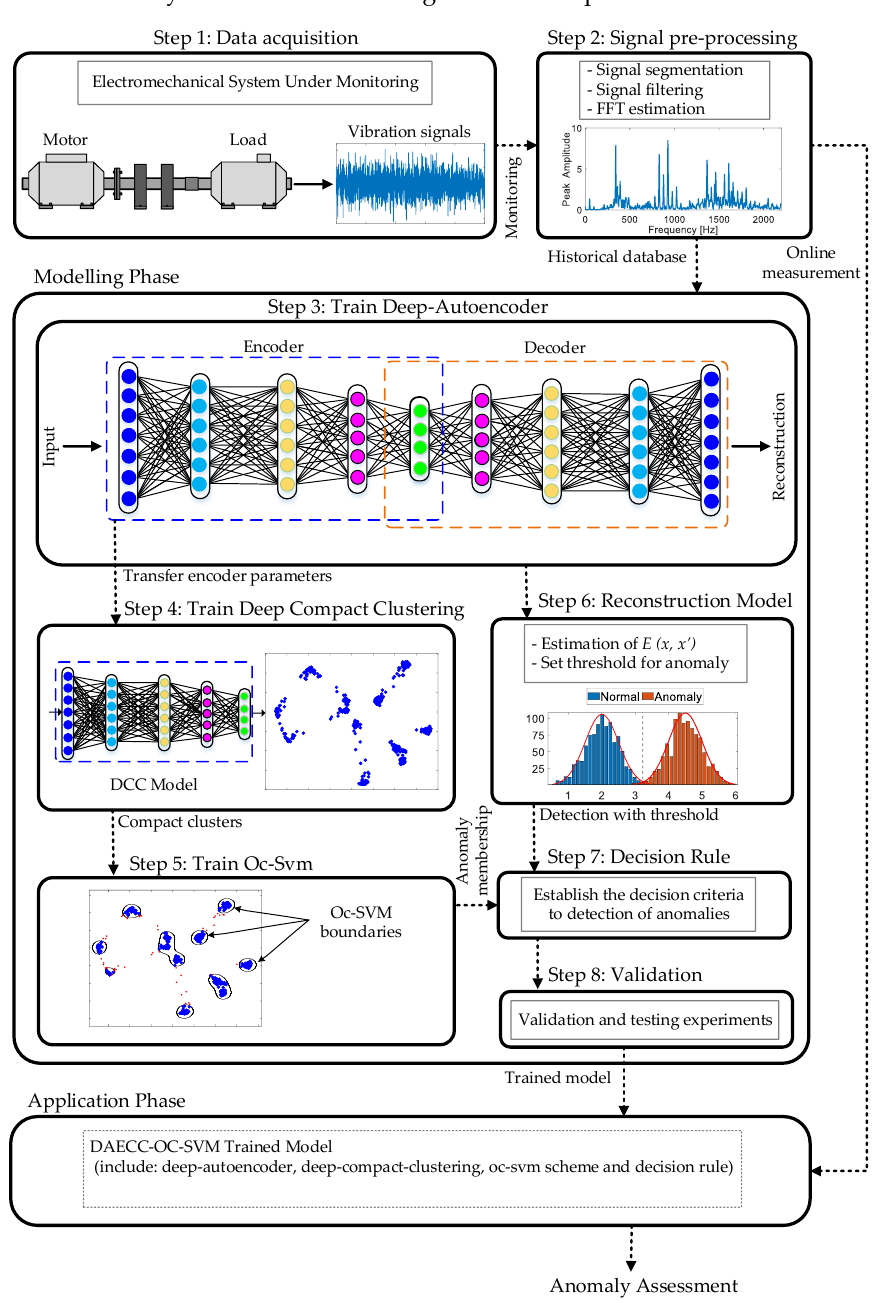
Figure 3. Framework of the proposed method. Step-by-step detailed flowchart of the proposed anomaly detection monitoring methodology.